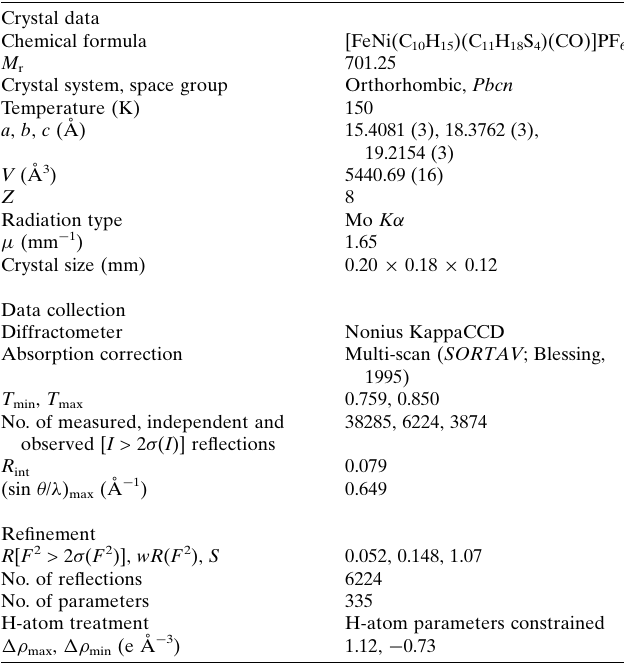
Table 1 Experimental details. Crystal data Chemical